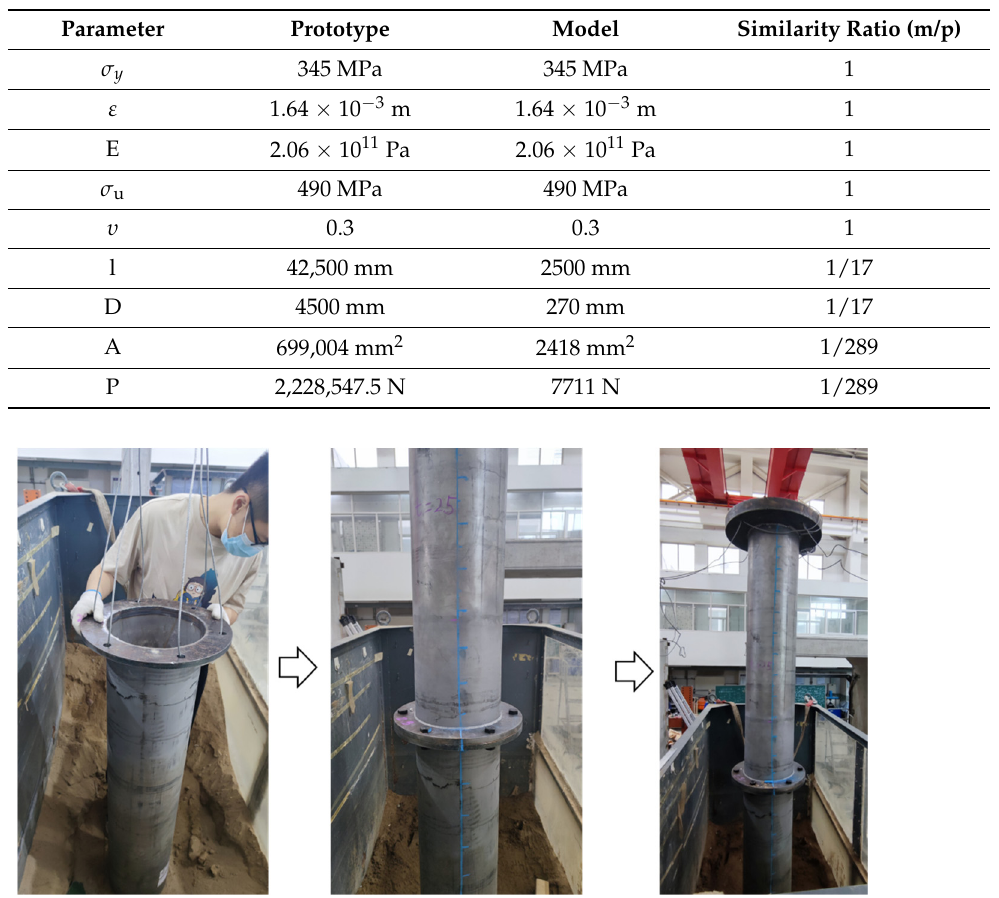
Figure 23. Installation of experimental model.